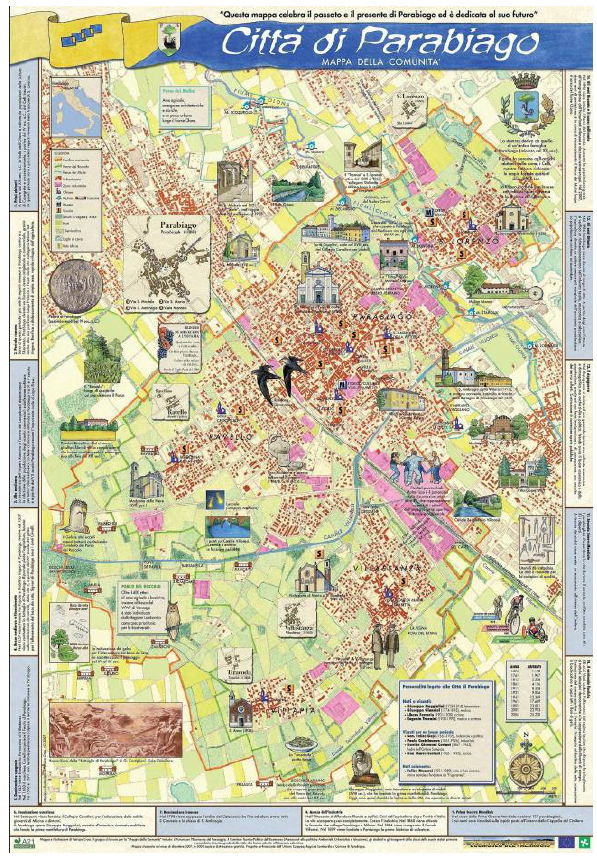
Figure 2. Example of a Community map on paper support (Parabiago ecomuseum, Lombardy